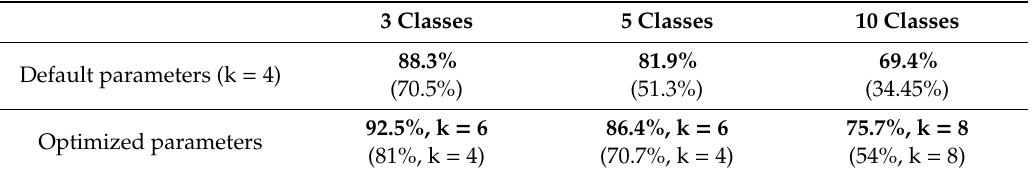
Table 5. Results by the WINkNN classifier compared to results by the “1 IN kNN classifier” (within parentheses) on the Spoken Digits dataset. The corresponding optimal “k” value is also